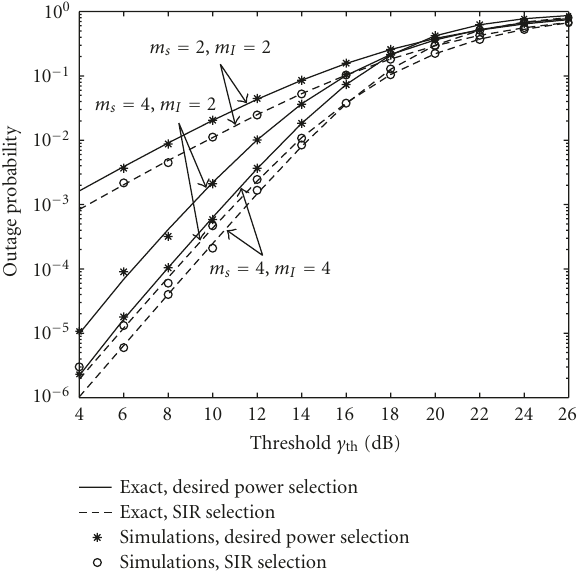
Figure 2: The e ff ect of changing the values of m s and m I on the performance of the SC receiver with L = 2, K = 2, β = 1, and SIR av = 15dB.